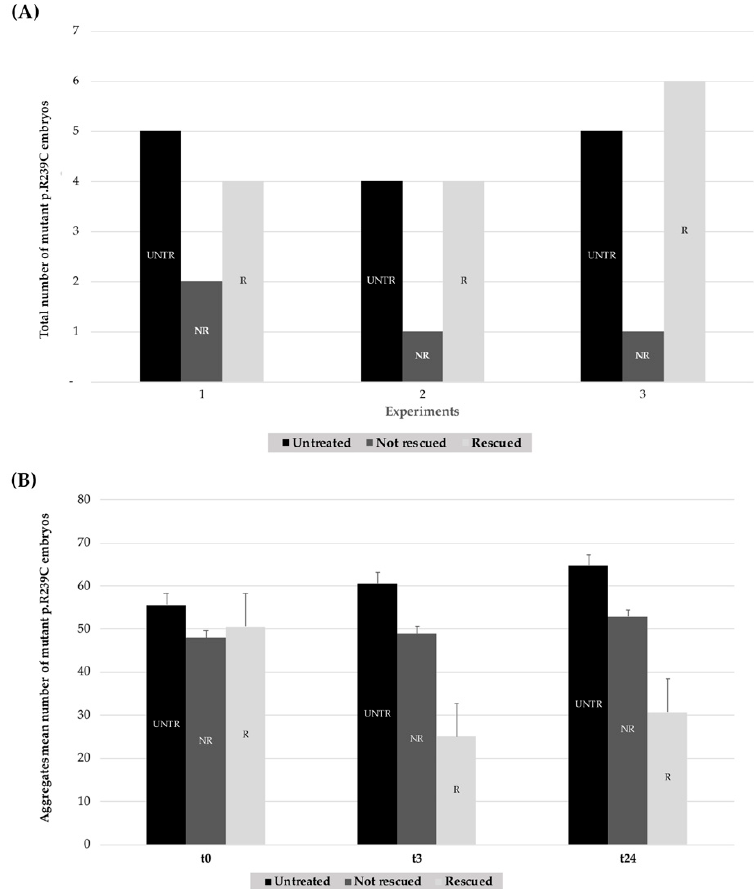
Figure 10. Summary histograms showing the e ff ect of heat-shock treatments on GFAP R239C-GFP-injected embryos from three replicates. ( A ) For each experiment (n ◦ 1–3), the lighter column of each series (R) represents the number of embryos showing a reduction in p.R239C aggregates, compared to the untreated embryos (UNTR) and the not rescued (NR) ones, the latter in which the thermal shock did not result in aggregate reduction. For “R” embryos, a paired t -test two-tailed p -value of 0.0022 was determined. ( B ) The respective count of aggregates is reported in the darker column for untreated embryos (UNTR), compared to the not rescued (NR) and the rescued (R) ones at t0 and after 3 (t3) and 24 h (t24). For “R” embryos, a paired t -test two-tailed p -value of 0.0048 was found. (UNTR: untreated, R: rescued, NR: not rescued). Table 4. Foreachexperiment, amongthetotalnumberofshockedembryos(“shocked”), embryospresenting a decreased number of aggregates (“rescued”) and the ones not showing any beneficial e ff ects (“not rescued”) are shown in table. The rescued are represented in terms of percentage (“% rescue”) with respect to the total number of shocked embryos. Percentages of mean value and standard deviation are shown at the bottom of the